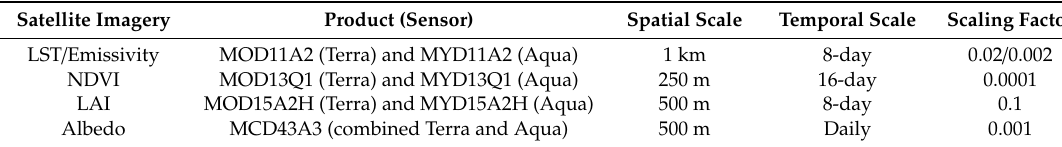
Table 4. The Moderate Resolution Imaging Spectroradiometer (MODIS) Satellite Images used in this study. LST stands for Land Surface Temperature, NDVI stands for Normalized Di ff erence Vegetation Index, and LAI stands for Leaf Area Index. All Product names such as MOD11A2 are standard product short names (as per MODIS naming conventions) used in the Land Processes Distributed Active Archive Center (LPDAAC) website (https: // lpdaac.usgs.gov / , accessed on 16 December